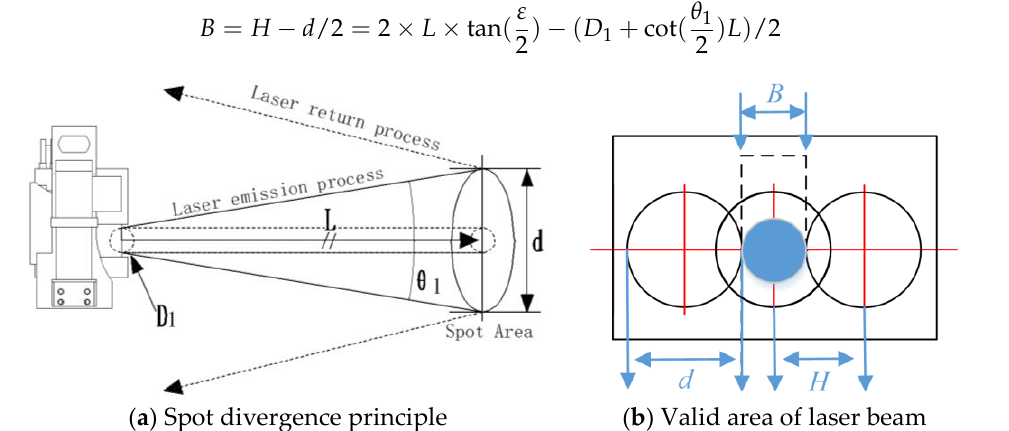
Figure 4. ( a ) Schematic of spot divergence principle with increasing distance. ( b ) The valid area of laser beam is layout of the distance between measured points at different angular resolutions.